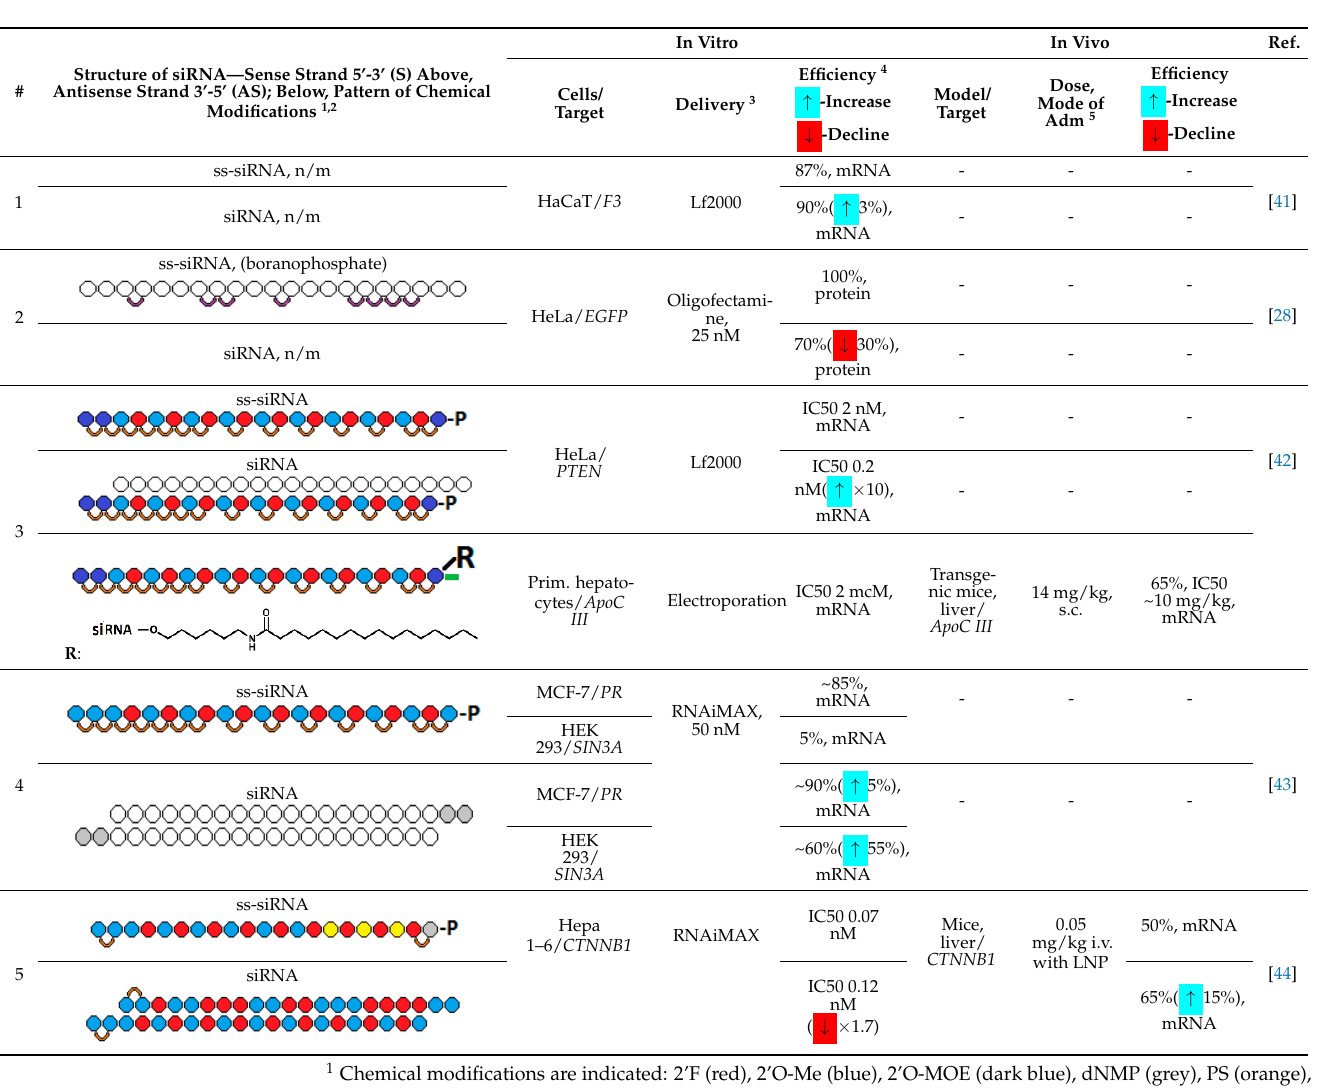
1 Chemical modifications are indicated: 2’F (red), 2’O-Me (blue), 2’O-MOE (dark blue), dNMP (grey), PS (orange), 5’-(E)-VP (green), inverted thymidine (black), boranophosphate modification